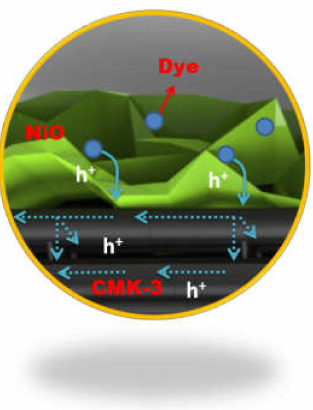
Figure 7. The schematic representation of the hole transfer path in the NiO / CMK-3